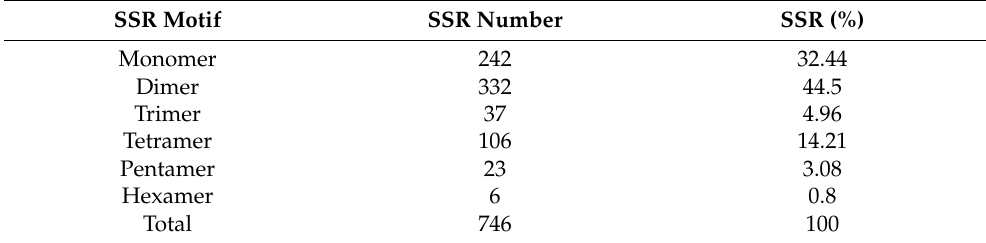
Table 2. Statistics of SSR motifs in the C. gigantocarpa mitochondrial